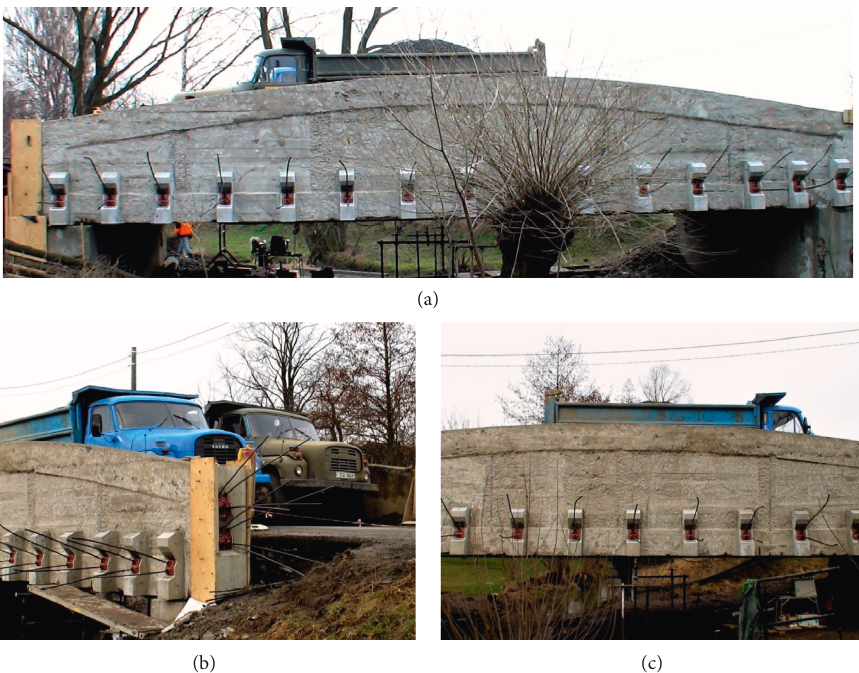
Figure 21: Static load test of the U-shaped bridge built in 1928 after strengthening [23]. The position of heavy vehicles (vehicles front and rear axles) in the longitudinal and transverse directions is described on the